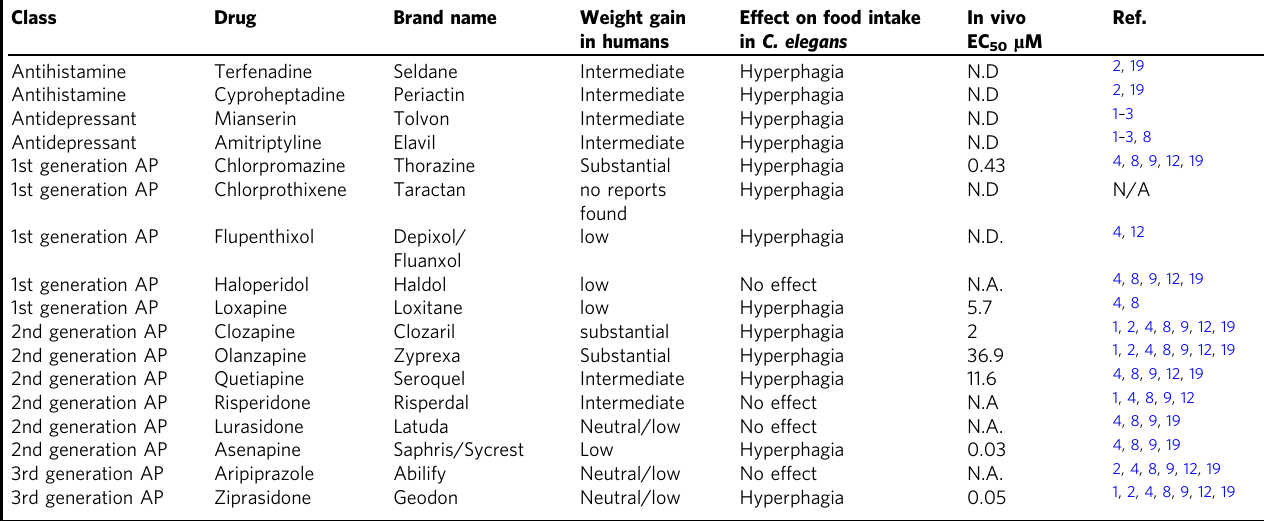
Table 1 Comparison of weight gain side-effect of various drugs in human patients with effect on food intake in C. elegans